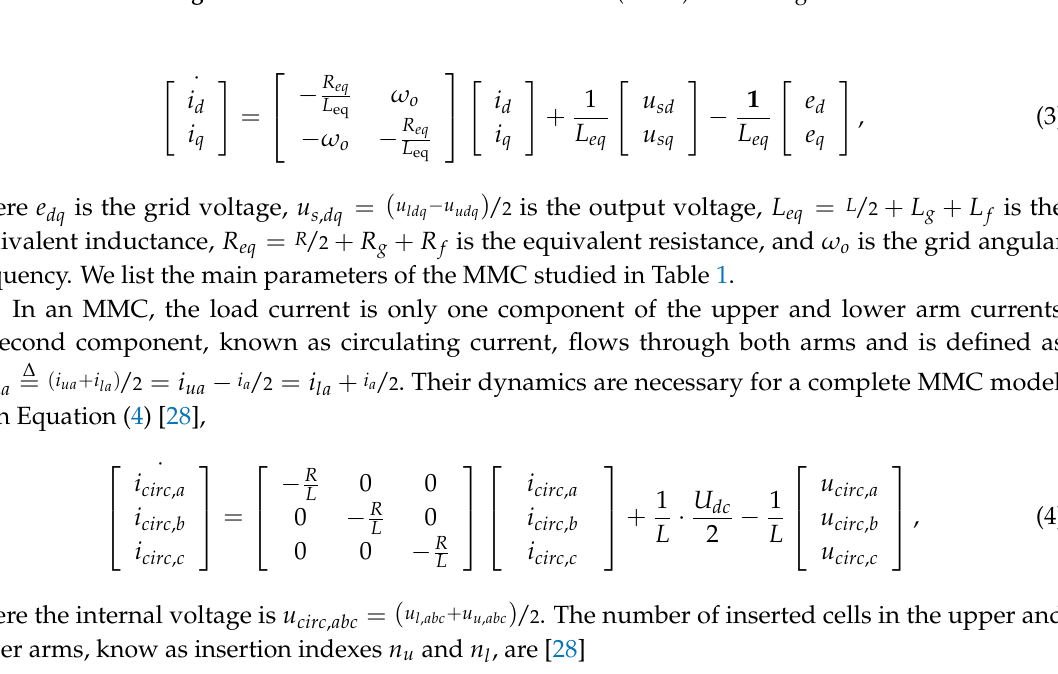
Figure 4. The Modular Multilevel Converter (MMC) circuit